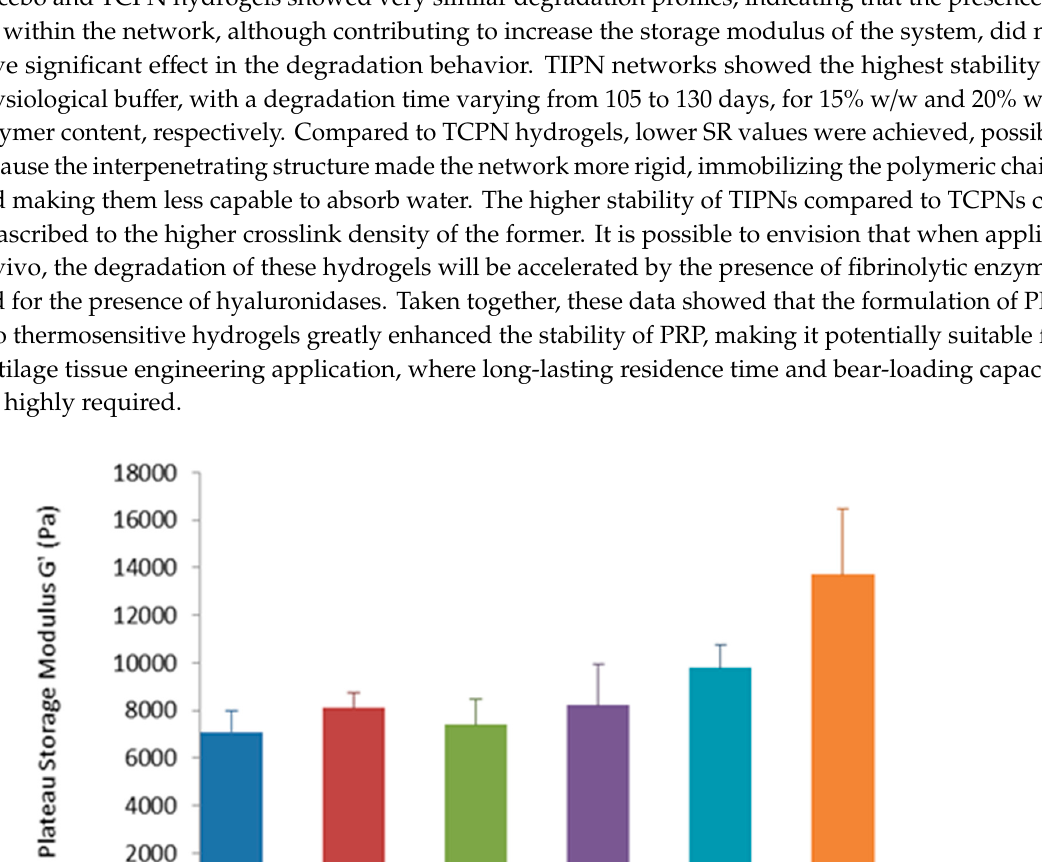
Figure 3. Comparison of plateau storage (G’) moduli for di ff erent hydrogel formulations.